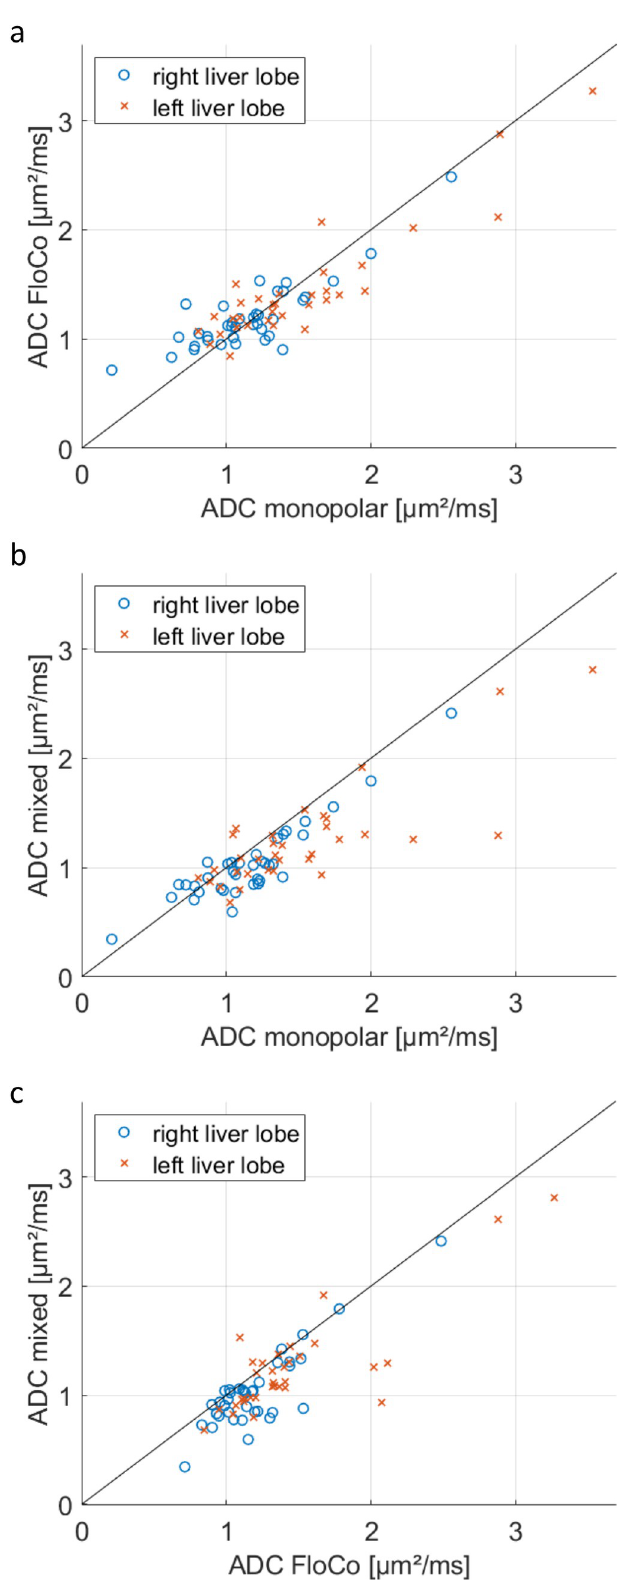
Fig 6. Individual subject ADC values for monopolar, FloCo, and mixed diffusion schemes. https://doi.org/10.1371/journal.pone.0268843.g006 PLOS ONE | https://doi.org/10.1371/journal.pone.0268843 May 26,